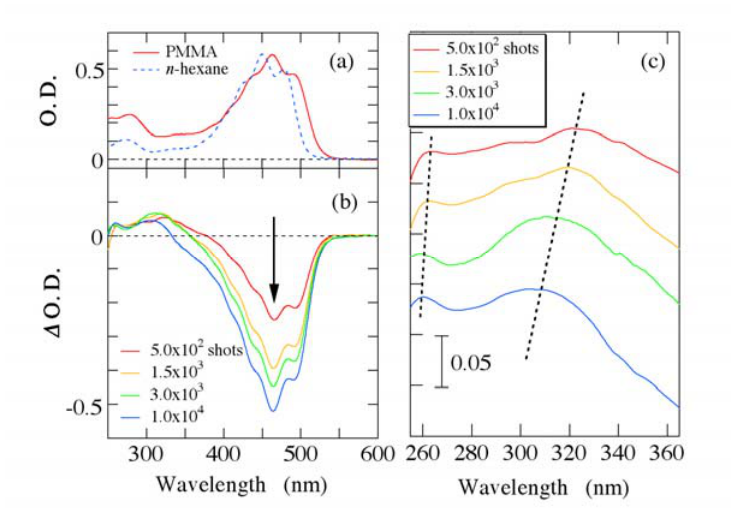
Figure 7. (a) Steady-state absorption spectrum of β -carotene in PMMA films, and (b) its absorbance change spectra after photoirradiation of the excitation laser pulses with an excitation density of 3 × 10 15 photons/cm 2 . The steady-state absorption spectrum of β -carotene in n -hexane solution with a concentration of 1 × 10 − 4 M is also indicated by a broken line. (c) The absorbance change spectra in UV light region are depicted on an appropriate enlarged scale with different offsets on y-axis.